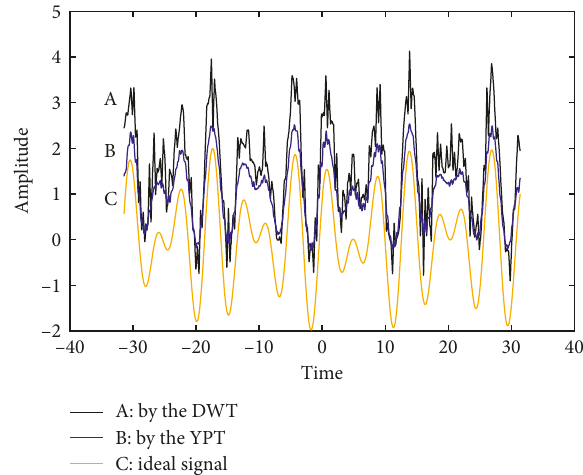
Figure 16: The new signals and ideal signal.